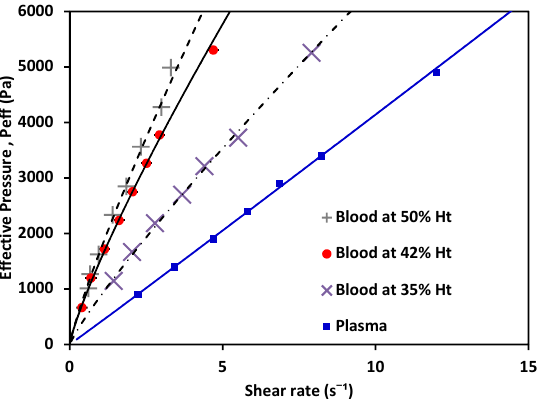
Figure 8. Effective pressure vs. shear rate of blood, a non-Newtonian fluid, at 50% Ht, 42% Ht, 35% Ht; and plasma, a Newtonian fluid.